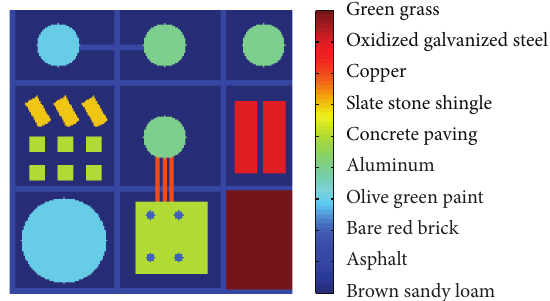
Figure 1: Spatial distribution of the different ground materials com- posing the